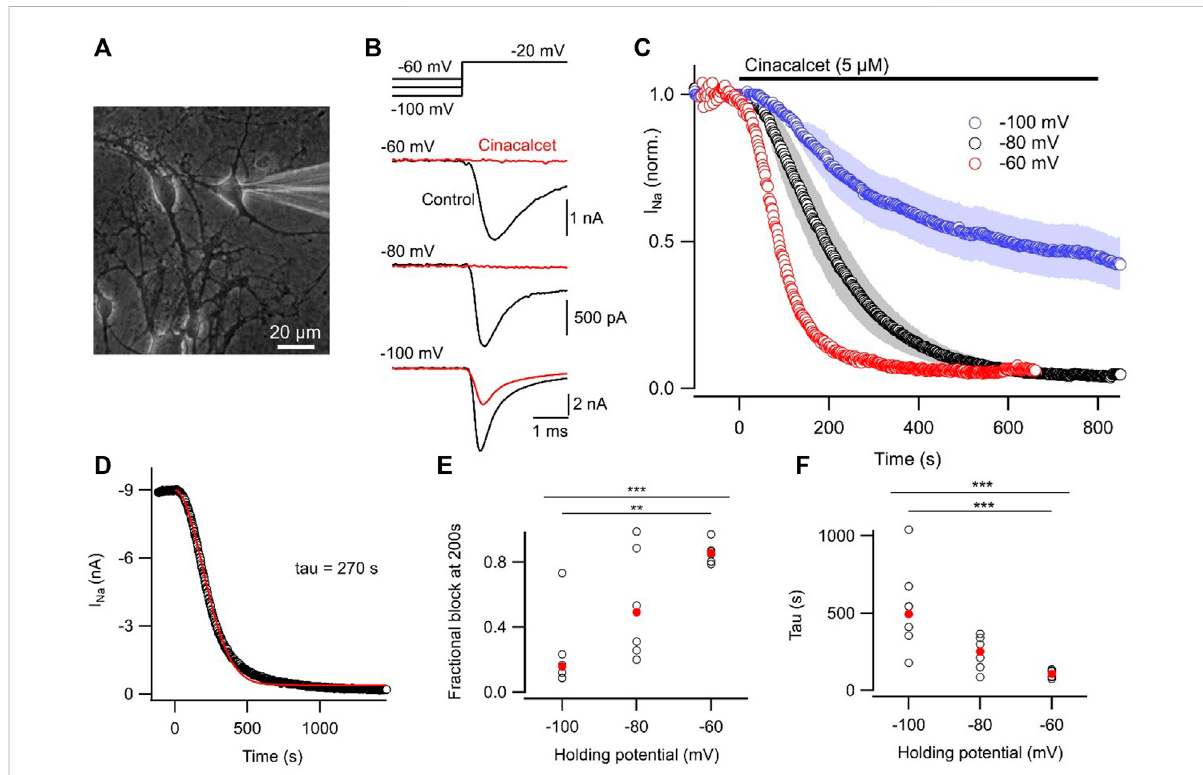
FIGURE 1 Inhibition of VGSC currents by cinacalcet is voltage-dependent. (A) Photomicrograph of neocortical culture with patch electrode in place. Whitebarindicates20 µm. (B) RepresentativevoltagetracesshowVGSCcurrentbaselinepriorto(control,black)andfollowingmaximalinhibitionby 5 µMcinacalcet(red).Cellswereheldat − 60, − 80,or − 100 mVandatestpulseto − 20 mVwaselicitedevery2 s. (C) Diaryplotofaveragenormalized peakVGSC current elicitedby20 mstestpulse every 2 sfromaholdingpotential of-60 (red,n=6),-80(black,n=6),or − 100 mV (blue,n= 6). Control current baseline was established prior to cinacalcet addition at time 0. (D) Exemplar diary plot of peak VGSC current elicited as in (B) following application of 5 µM cinacalcet. Data fi t with Eq. 1 shown in red. (E) Plot of individual (black, open circles) and median (red, fi lled circles) values of fractional inhibition at 200 s after application of 5 µM cinacalcet. Kruskal – Wallis test returned p < 0.001 overall, with p = 0.690, 0.003, and 0.090 for − 60 mV versus − 80 mV, − 60 mVvs. − 100 mV, and − 80 mVvs. − 100 mV respectively byDunn ’ scorrectedmultiple comparisons. Here and in later Figures p values designated as follows: * p < 0.05, ** p < 0.01, and *** p < 0.001. (F) Plot of individual (black, open circles) and mean (red, fi lled circles) values of tau (left). KW test returned p < 0.001 overall, with p = 0.189, 0.0008, and 0.192 for − 60 mV versus − 80 mV, − 60 mV vs. − 100 mV, and − 80 mV vs. − 100 mV respectively by Dunn ’ s corrected multiple